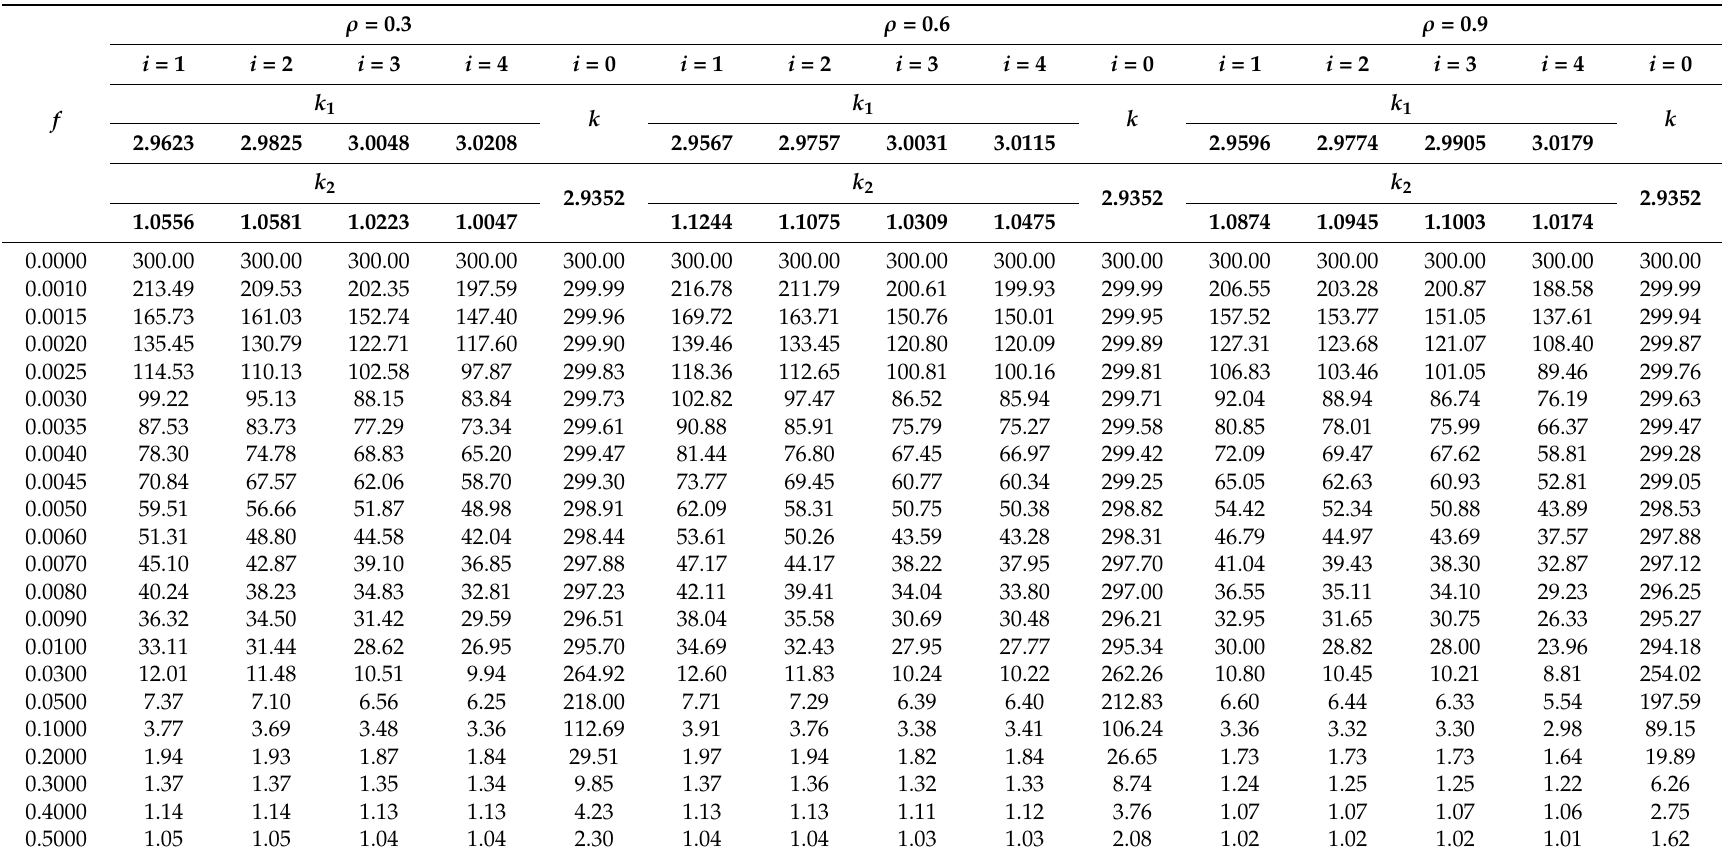
Table 2. The ARL analysis for 300 with n =